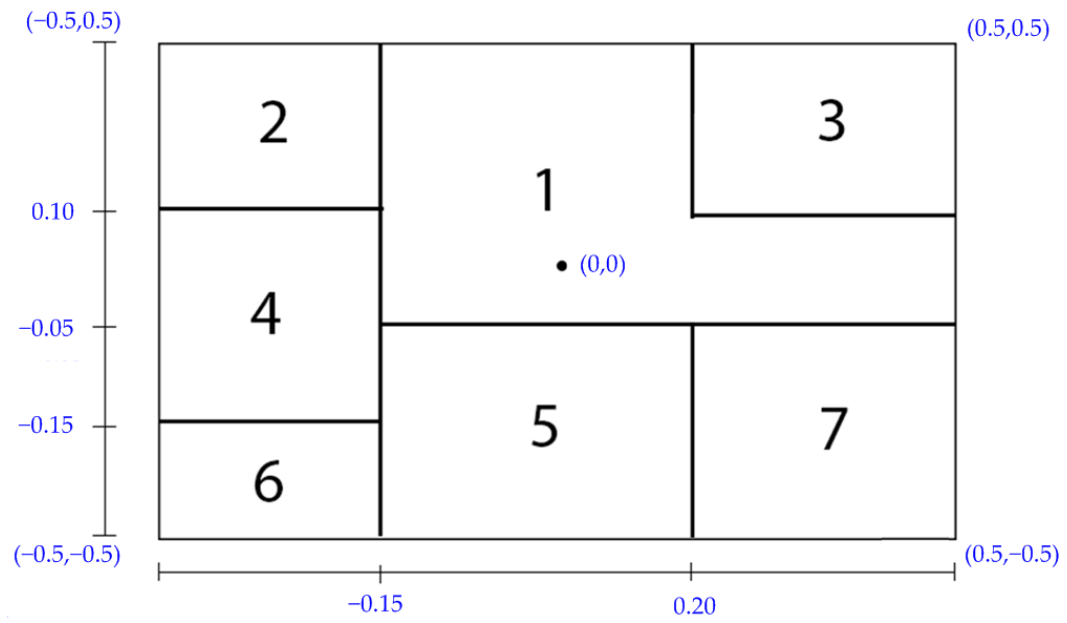
Figure 6. Structure of the decision maker as a function of the different regions.